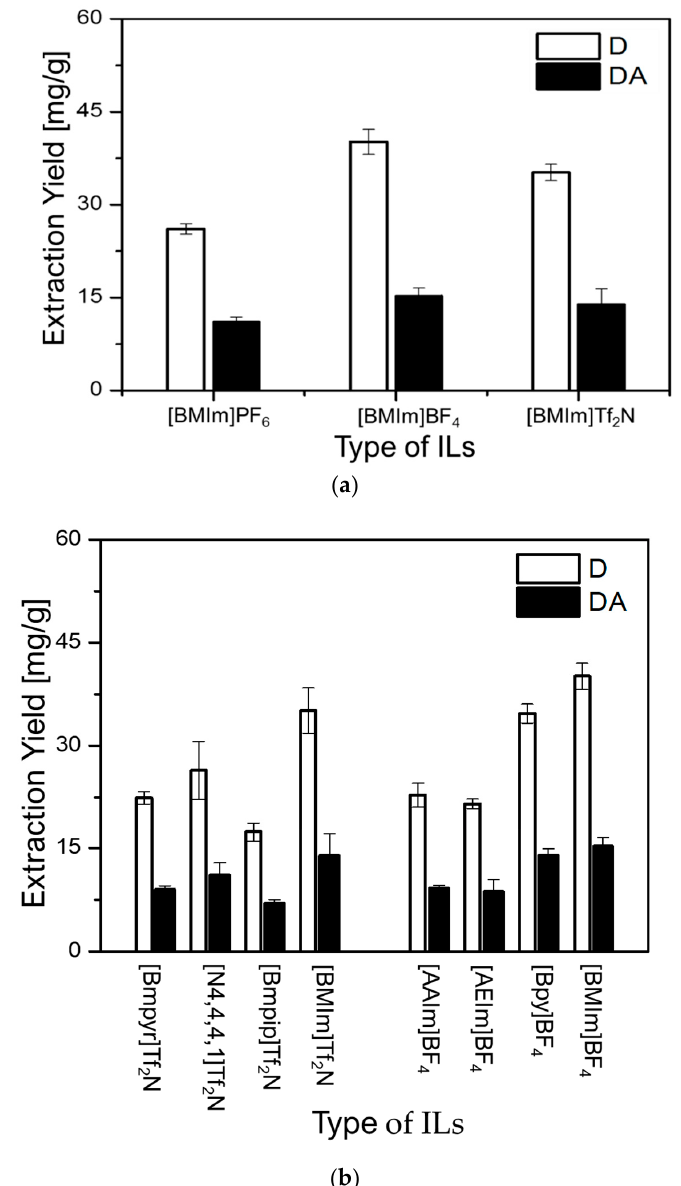
Figure 3. E ff ect of ILs on the extraction yields of D and DA: ( a ) e ff ect of anions and ( b ) e ff ect of